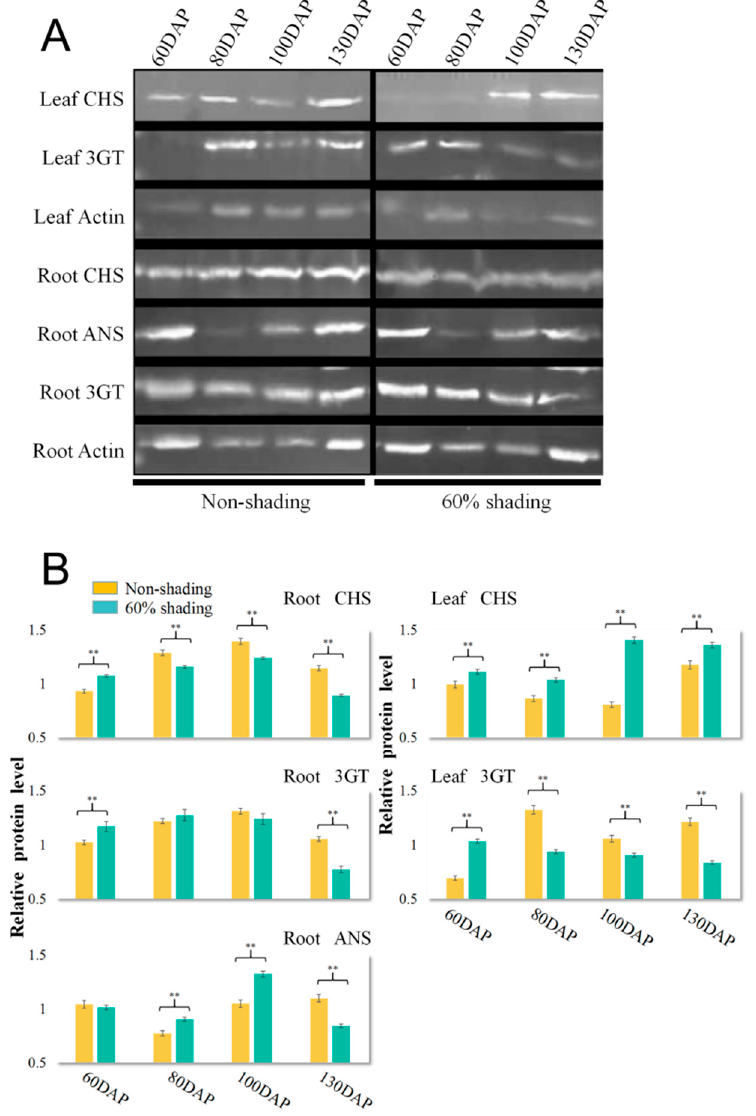
Figure 7. Protein expression analysis of three key enzymes in the flavonoid pathway, CHS, ANS and 3GT, from PSP. ( A ) western blotting results of CHS, ANS and 3GT in leaves and storage roots at 60–130 DAP. ( B ) Protein expression analysis of three key enzymes between the 60% shading treatment and the control. Data represent the mean ± SD of two individual plants (n = 2) with tissue-mixed samples of functional leaves or storage roots per plant. The asterisks represent significant differences by Student’s t -test (**, p < 0.01). The columns of relative protein expression from PSP storage roots under 60% shading treatment are shown with green filling and those under nonshaded conditions are shown with yellow filling. chalcone synthase, CHS; anthocyanidin synthase, ANS; UDP glucose flavonoid 3-O-glycosyltransferase, 3GT; purple-fleshed sweet potato, PSP.